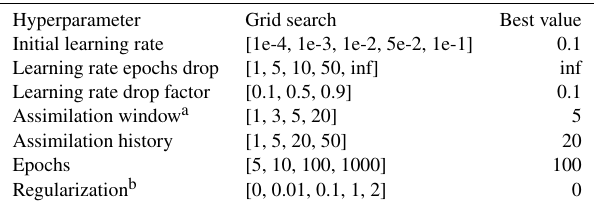
Table F1. Data assimilation hyperparameter tuning grid search and final